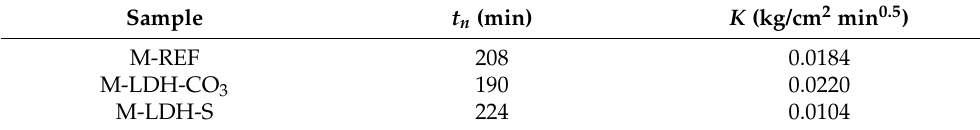
Table 1. Water capillary absorption coefficients estimated according to the Fagerlund method [30].